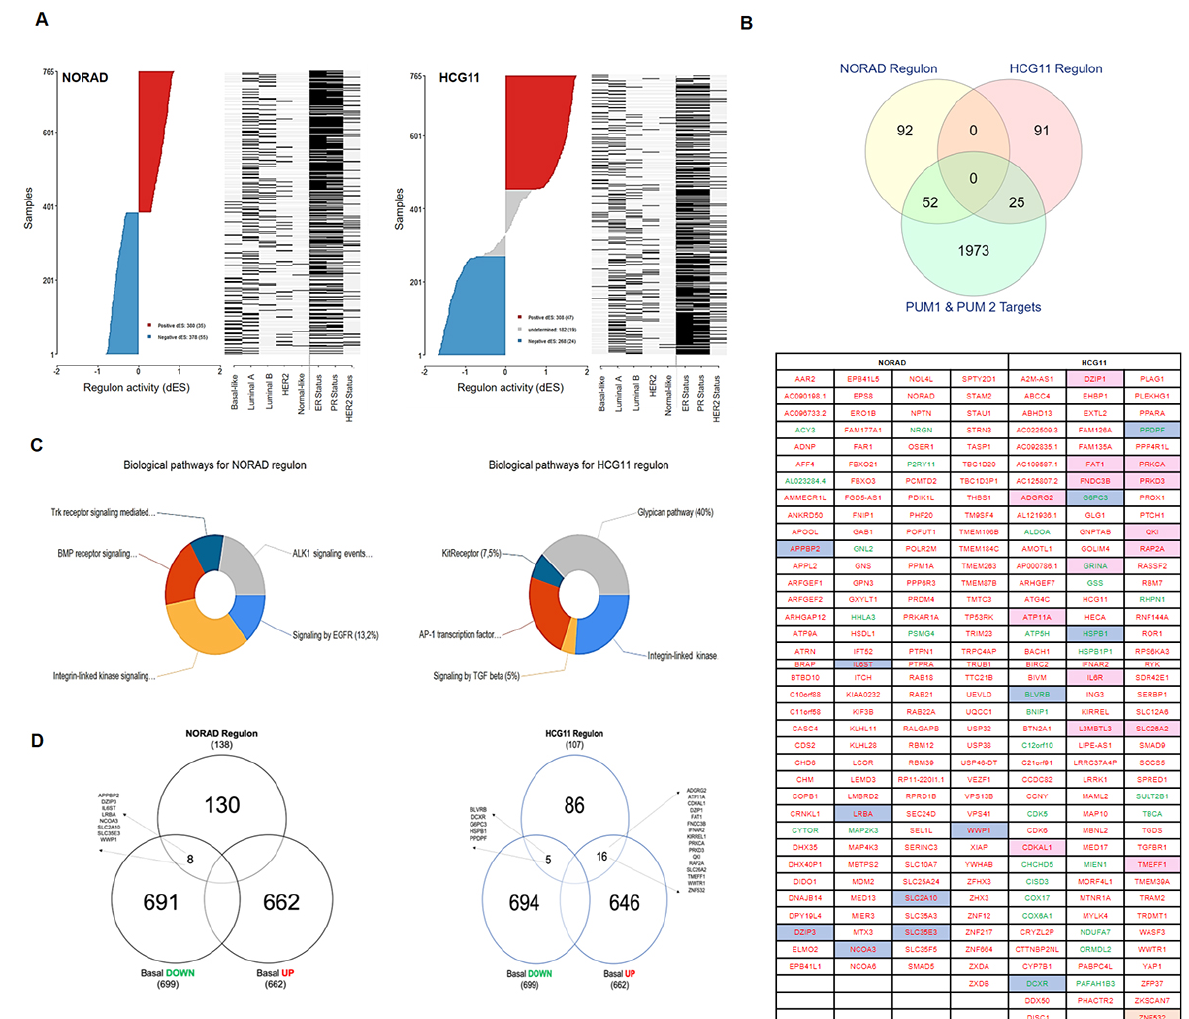
Figure 3 – Ranked dES plot for NORAD and HCG11 using TCGA data. (A) Stratification of TCGA cohort-based on regulon activity and status of the key attributes: ER, PR, and HER2 status. The red section of the plot indicates regulon activation, and the blue section regulon repression. (B) Venn diagram showing the intersection among NORAD and HCG11 regulons and the potential PUMILIO targets; gene list is representing the gene set from both regulons. Genes that present positive or negative mutual information in each regulon are shown in red or green, respectively. Those that are also up or down-regulated in the basal-like signature are shown in blue or pink cells, respectively. (C) Gene Ontology (GO) analysis of the HCG11 and NORAD regulons indicated in (B). (D) Comparison among molecular signatures for the basal-like (up and down-regulated protein-coding genes) with regulons for NORAD and